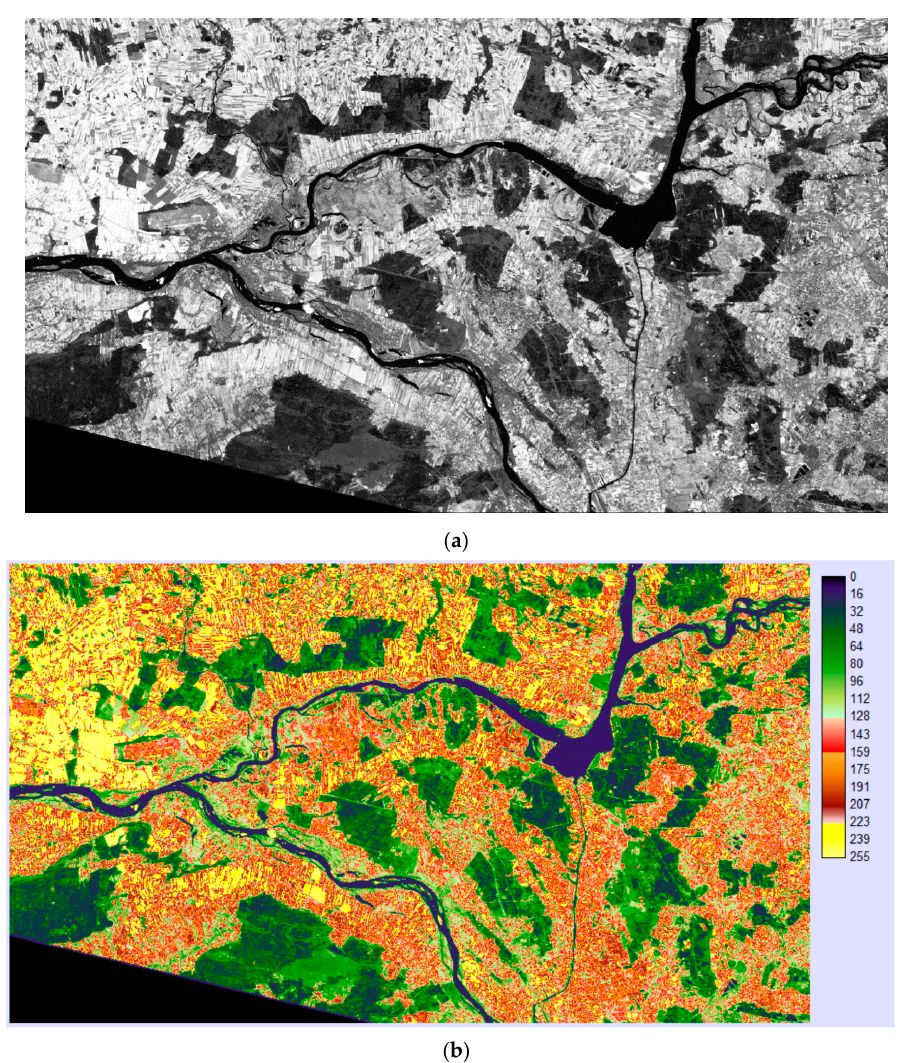
Figure 4. ( a ) Visualization of a single band, greyscale image of the transformed and rescaled outcome of the RS algorithm application on an original Landsat ETM+ satellite image, involving information from all nine spectral band components. ( b ) Visualization of single band, pseudo-color, 256 classes of transformed and rescaled image, outcome of the RS algorithm application, involving information from all nine spectral bands components.